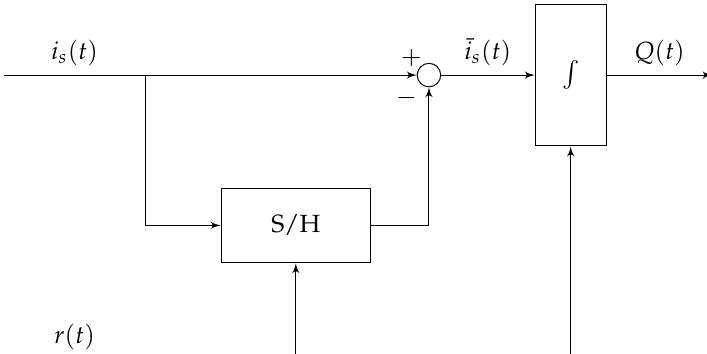
Figure 7. Schematic used for the implementation of the IDIM technique, including an offset-eliminating stage and an analog integrator with reset capability, adopted from [26].